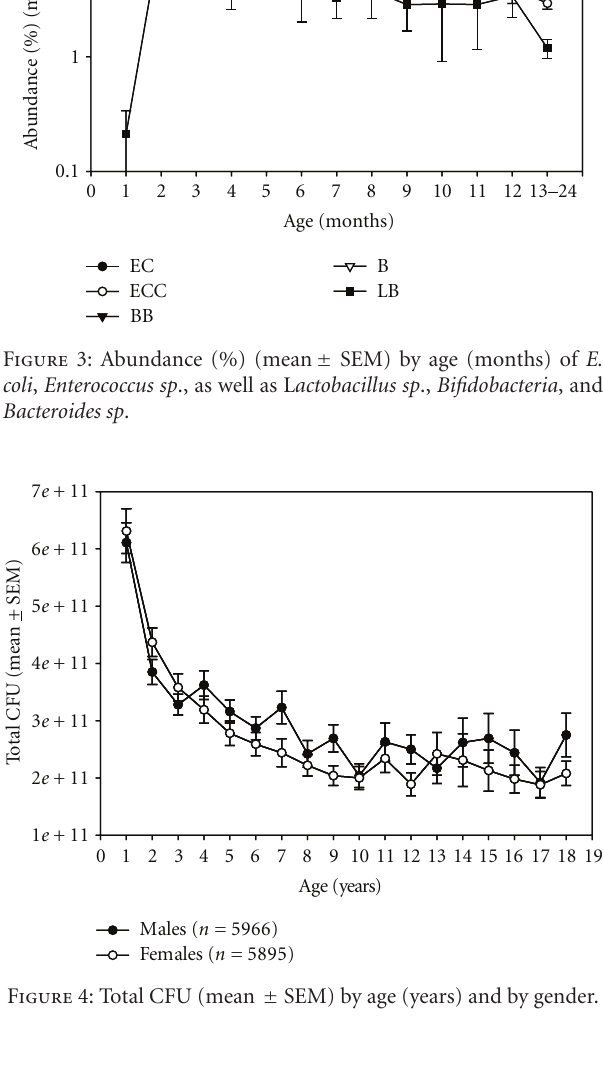
. 001 and F = 2 . 884, P = . 001, resp.) while Bacteroides